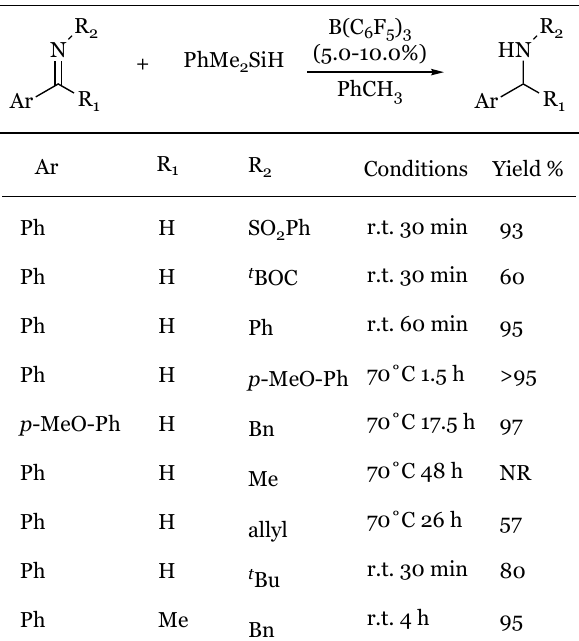
Figure 42. Reaction rate and yield in the reduction of imines based on substituents.